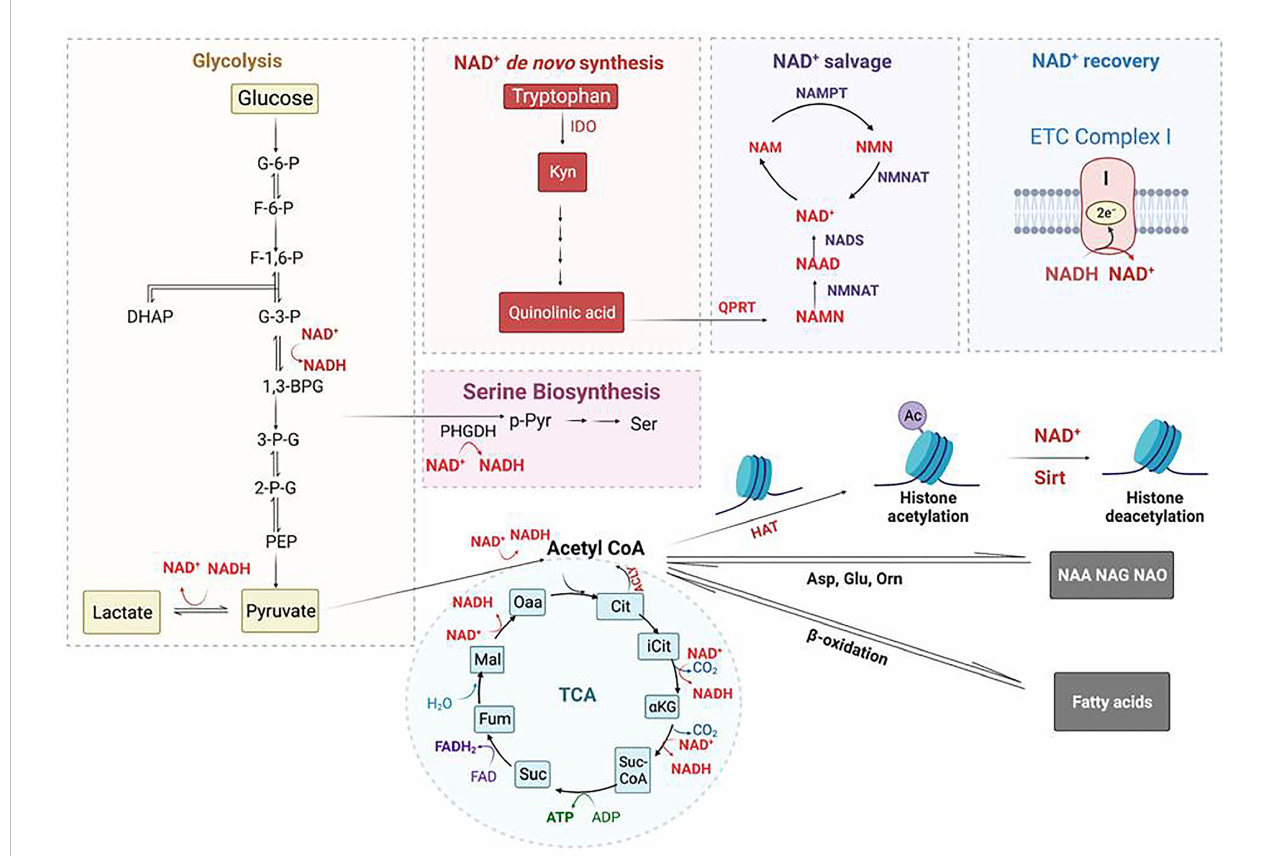
FIGURE 5 Regulation of Histone acetylation and deacetylation by metabolism-generated acetyl-CoA and NAD + . Acetyl-CoA is an essential co-substrate of histone acetyltransferase (HAT) that is mainly generated from glycolysis and fatty-aid b -oxidation; it is required for histone acetylation, amino acid acetylation including forming n-acetyl-aspartate (NAA), n-acetyl-glutamate (NAG), and n-acetyl-ornithine (NAO), and fatty-acid synthesis. NAD + is an essential co- substrate of NAD + -dependent histone deacetylases that includes Sirtuin proteins. NAD + is consumed by glycolysis (2 molecules) and TCA cycle (3 molecules), whereas it is regenerated from NADH oxidation via conversion of pyruvate into lactate and through ETC complex I. NAD + is biosynthesized from quinolinic acid, the end product of tryptophan metabolism, catalyzed by the rate-limiting enzyme quinolinate phosphoribosyl transferase (QPRT). The NAD + de novo biosynthesis pathway is coupled with and regulated by the NAD + salvage pathway. Regulation of NAD + usage and production in M F s controls Sirt deacetylase activity, and hence, histone acetylation level. Additional Symbols : ACLY, ATP-citrate lyase; NAM, niacinamide;